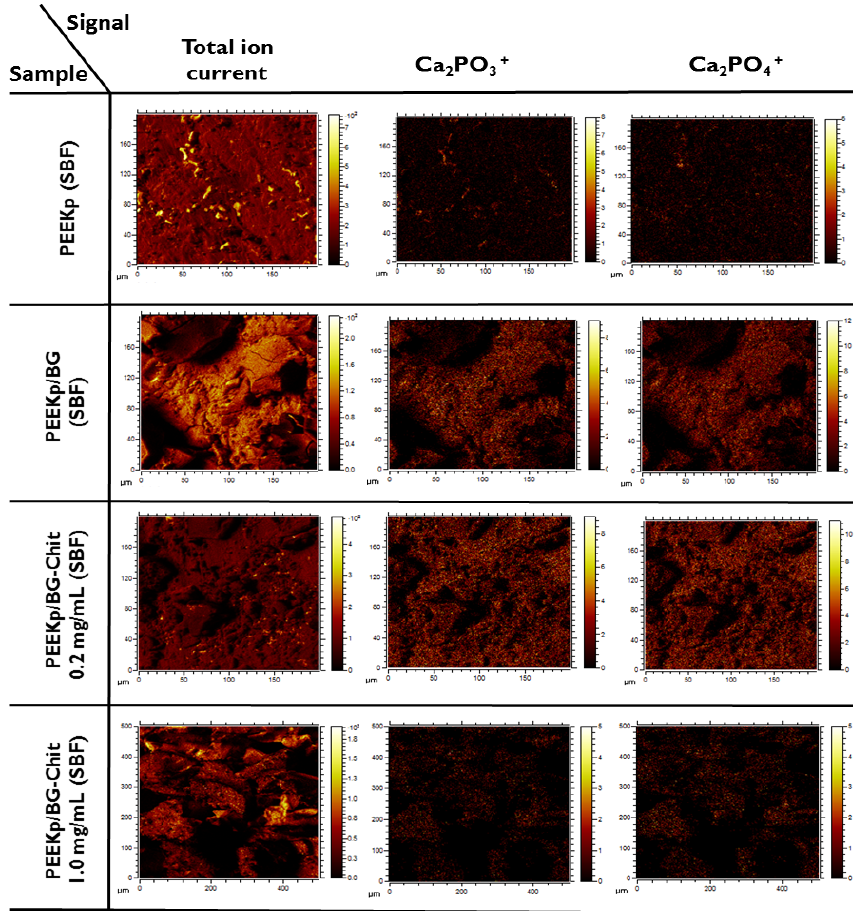
) and Ca 2 PO + 3 4